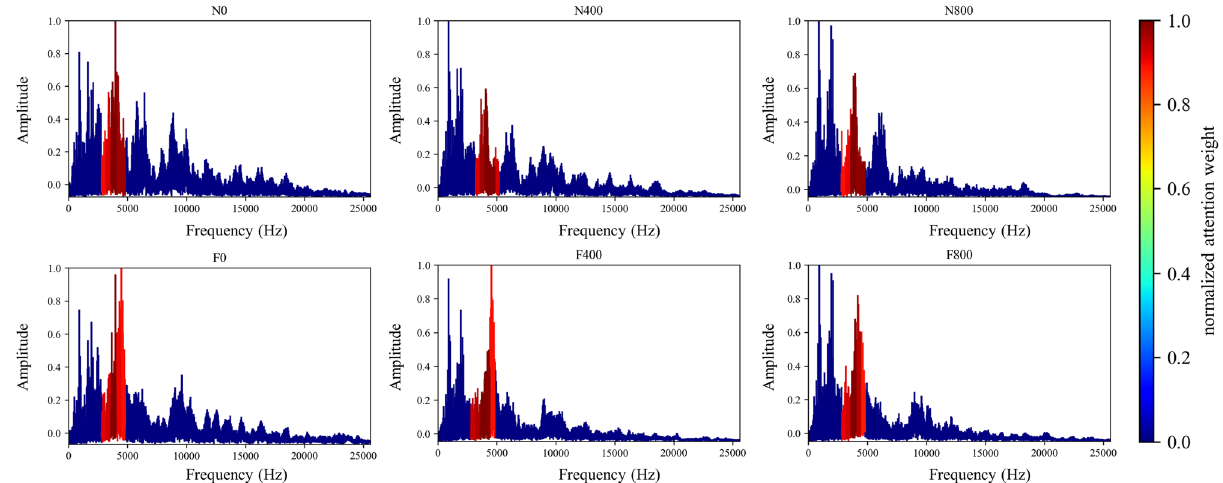
Figure 20. Visualization of attention weight in the Local